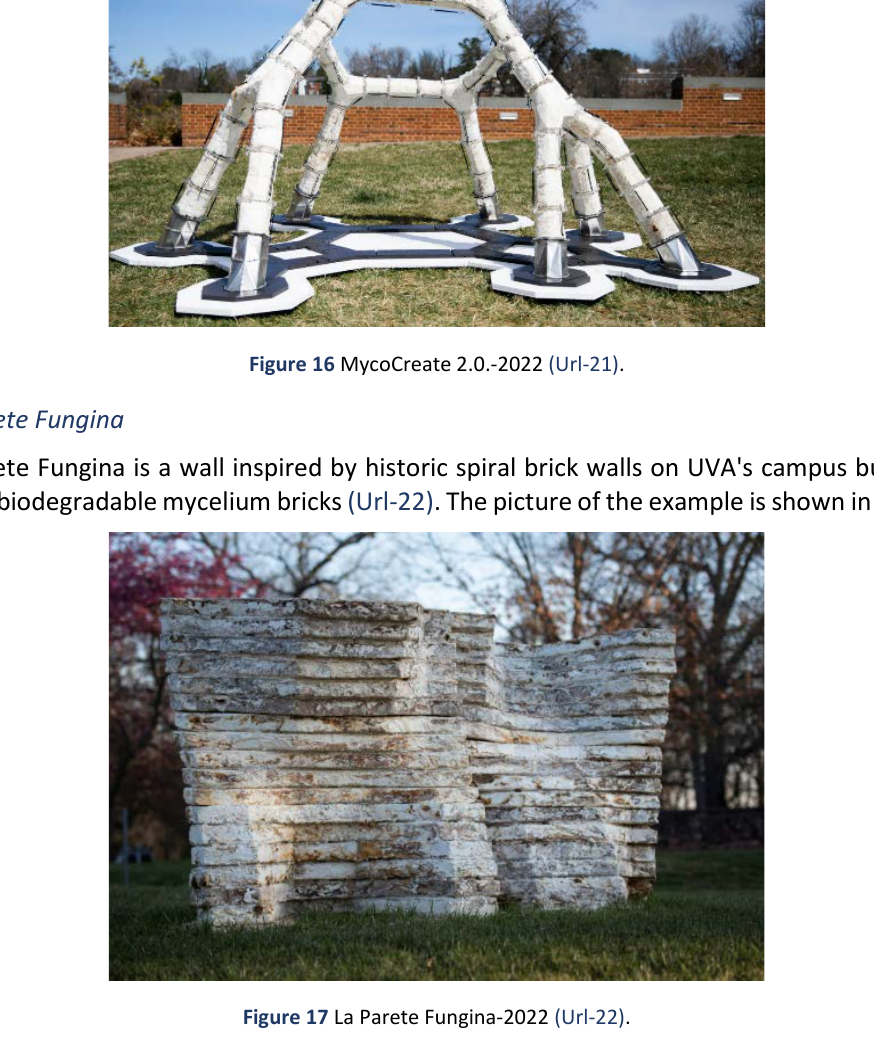
Figure 17 La Parete Fungina-2022